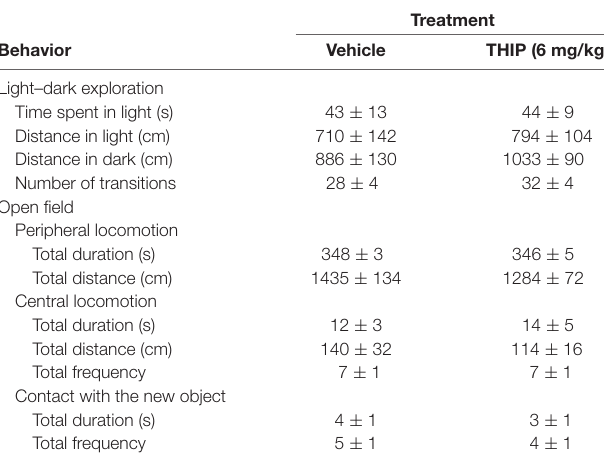
TABLE 1 | Anxiety-like behavior in light:dark exploration and open-field tests 2 h after acute THIP treatment in adult male C57BL/6J mice.